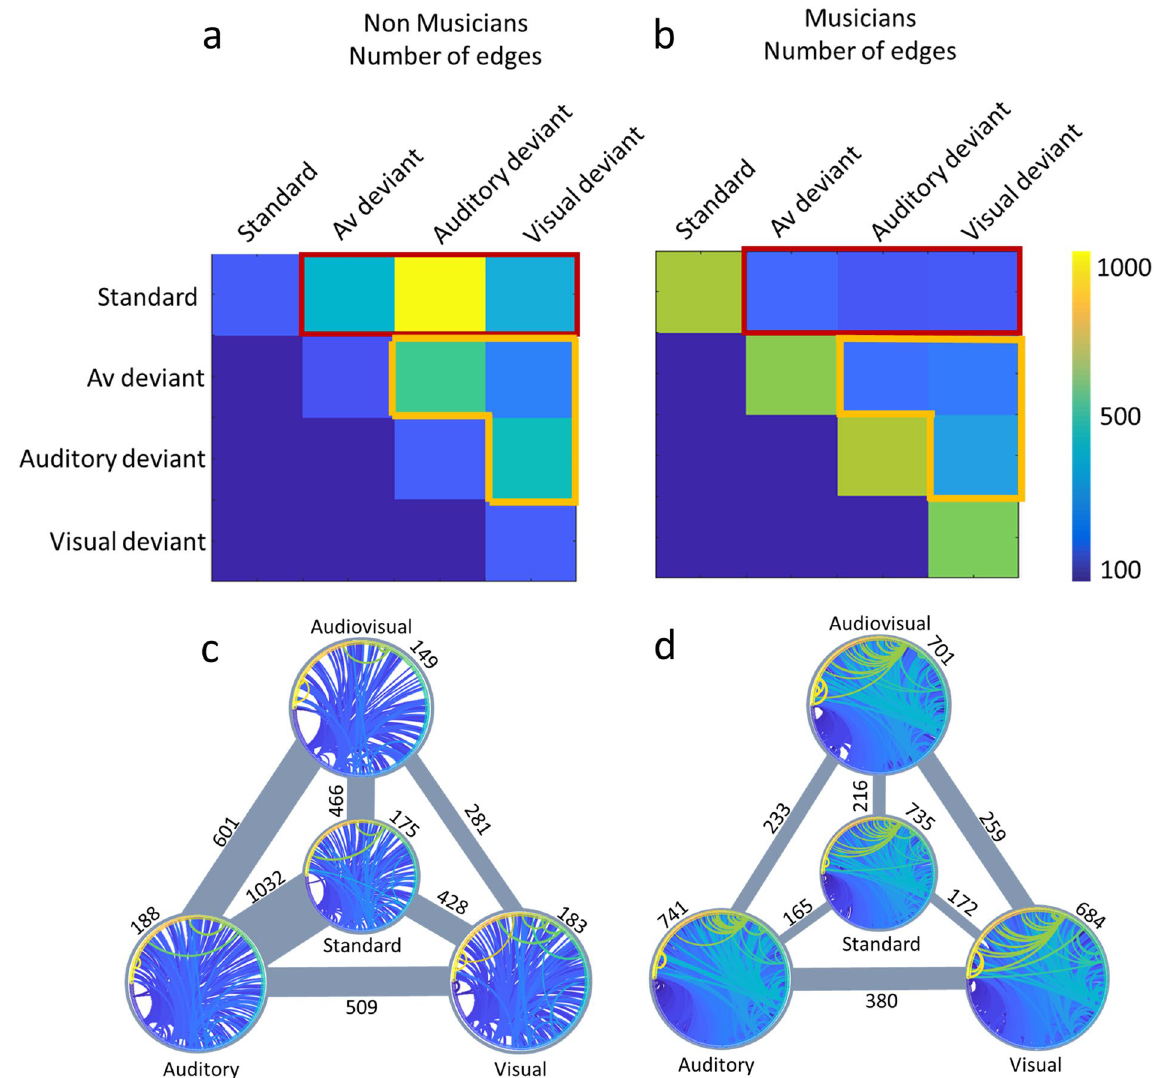
Figure 5. Functional connectivity amongst the different sensory modalities and music related neuroplasticity: task-defined networks depicting inter- and intra- modal functional connectivity for musicians and non- musicians. ( a ): Adjacency matrix representing the graph of non-musicians, showing number of edges via color scaling for each modality and their interactions. ( b ): Adjacency matrix representing the graph of musicians, showing number of edges via color scaling for each modality and their interactions. ( c ): Within and between task-defined network state connectivity of non-musicians. Number of edges between states is represented via line’s size, number of edges within states is given by a circular representation of the network. ( d ): Within and between task-defined network state connectivity of musicians. Number of edges between states is represented via line’s size, number of edges within tates is given by a circular representation of the